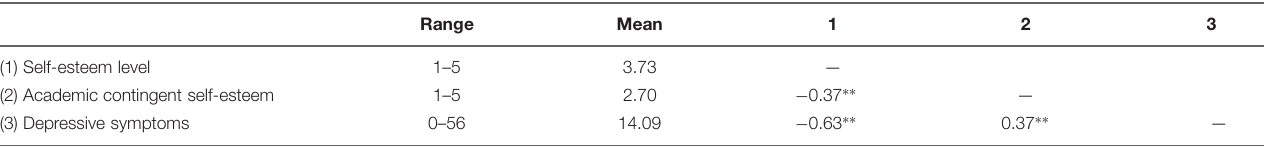
TABLE 1 | Possible range, mean scores, and intercorrelations of self-esteem (SE) level, academic contingent self-esteem (aCSE), and depressive symptoms (DS). Range Mean 1 2